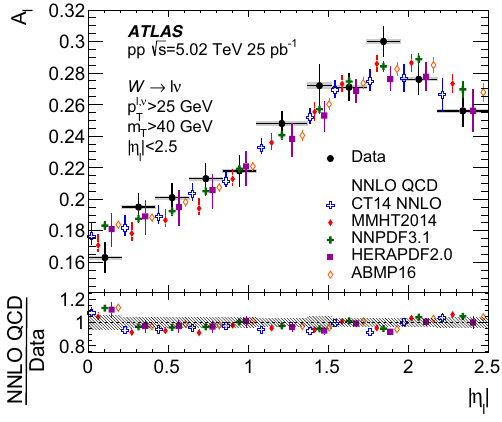
Fig. 12 Differential cross section for Z boson production as a func- tion of absolute lepton-pair rapidity compared with theoretical predic- tions. Statistical and systematic errors are shown as corresponding bars and shaded bands on the data points. The luminosity uncertainty is not included. Only the dominant uncertainty (PDF) is displayed for the the- ory. The lower panel shows the ratio of predictions to the measured differential cross section in each bin, and the shaded band shows the sum in quadrature of statistical and systematic uncertainties of the data